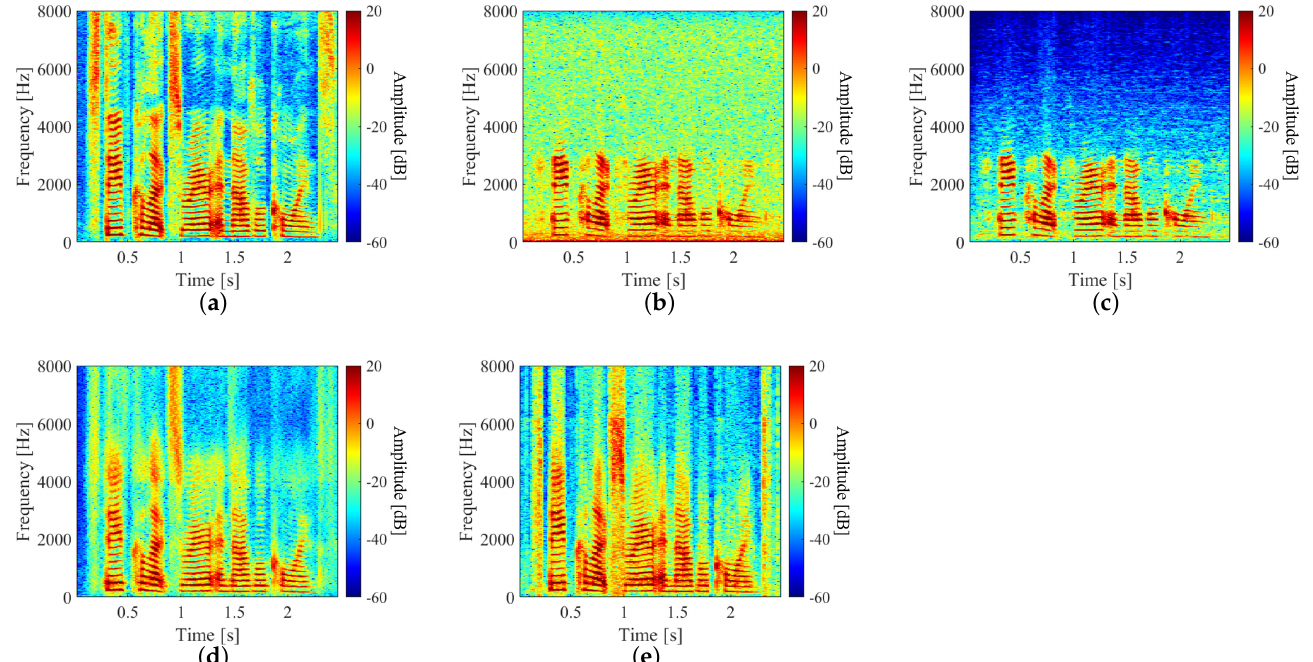
Figure 15. Examples of clean, observed, and enhanced speech spectrograms: ( a – e ) are clean speech, observed speech, speech enhanced with the conventional method, speech enhanced with proposed STFT-based method, and speech enhanced with the proposed waveform-based method, respectively. Table 3. Objective evaluation result of each